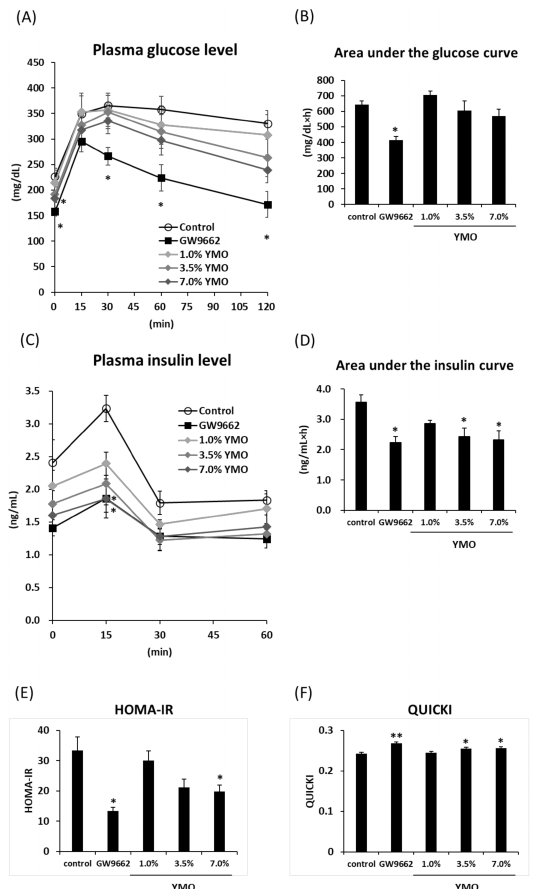
Figure 5. Effect of YMO on plasma glucose and insulin levels during oral glucose tolerance test (OGTT) in KK-A y mice. OGTT was performed at 15 week of animal experiment. Plasma glucose level ( A ), area under the glucose curve ( B ), plasma insulin level ( C ), area under the insulin curve ( D ), homeostasis model assessment-insulin resistance (HOMA-IR) ( E ), quantitative insulin-sensitivity check index (QUICKI) ( F ) were measured in KK-A y mice fed with 1.0, 3.5, or 7.0% YMO. Values are mean ± SE, n = 7–10 ( A , B ) and n = 5–7 ( C – F ). ** p < 0.01, * p < 0.05 versus